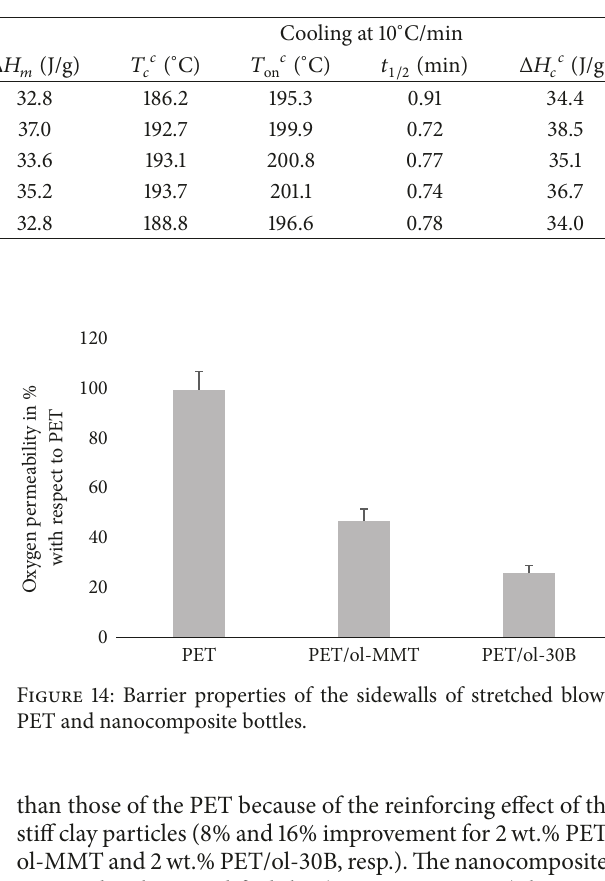
Table 3: DSC results of 2 wt.% PET/MMT, PET/ol-MMT, PET/30B, and PET/ol-30B nanocomposites.